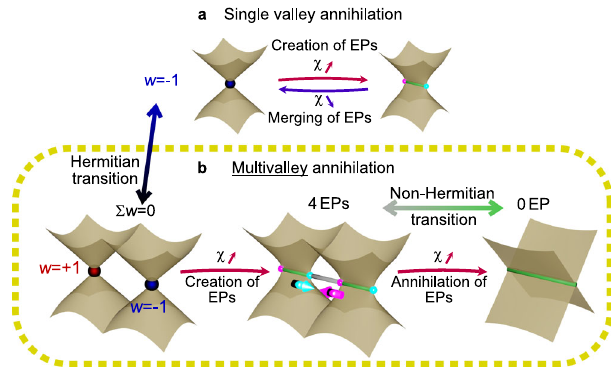
Fig. 1 | Difference between previously considered EP annihilation and this work. a Typical EPannihilationwhereonly a single Dirac valley isinvolved. EPs are created from a DP whenincreasing the relative non-Hermiticity χ . Conversely, they mergeandformaDPwhentherelativenon-Hermiticitydecreases. b Annihilationof EPsdescribed inthiswork, involving differentvalleys.4EPsarecreatedfrom2DPs when increasing the relative non-Hermiticity. When it is increased further, the EPs meet and annihilate, leaving the system without any singularity. w is here the winding